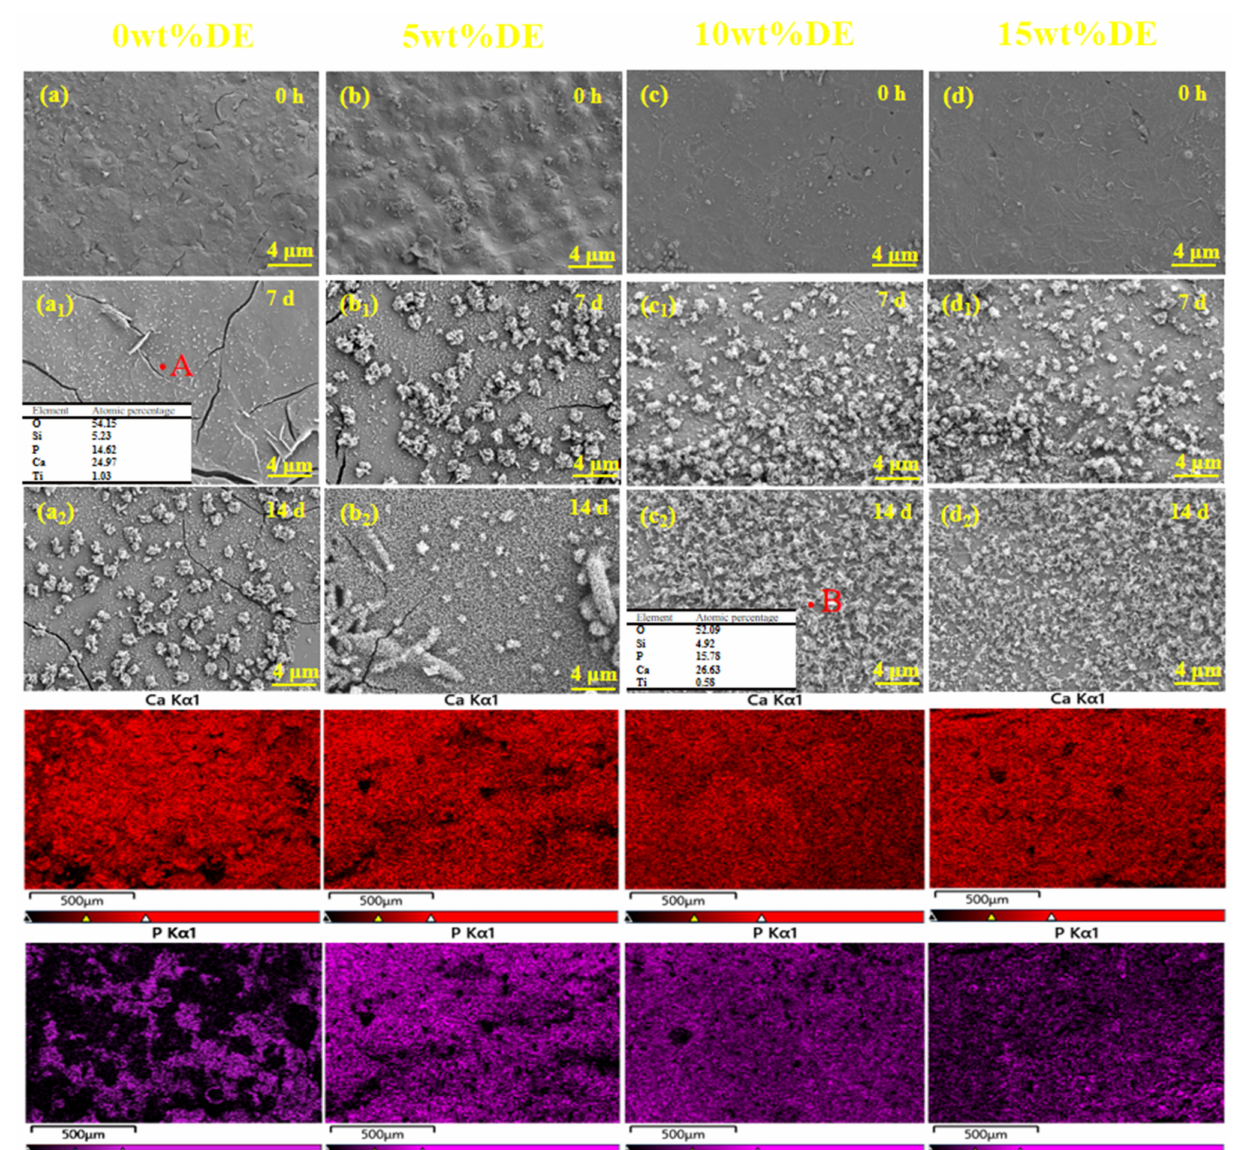
Figure 8. The biomineralization of Ca-P coatings after being soaked in SBF for 7 d and 14 d including: surface morphologies of coatings without soaking ( a – d ), and coatings after soaking in SBF for 7 d ( a 1 – d 1 ) and 14 d ( a 2 – d 2 ); EDS point scan of points A and B, and elemental mapping images of calcium and phosphate after soaking in SBF for 14